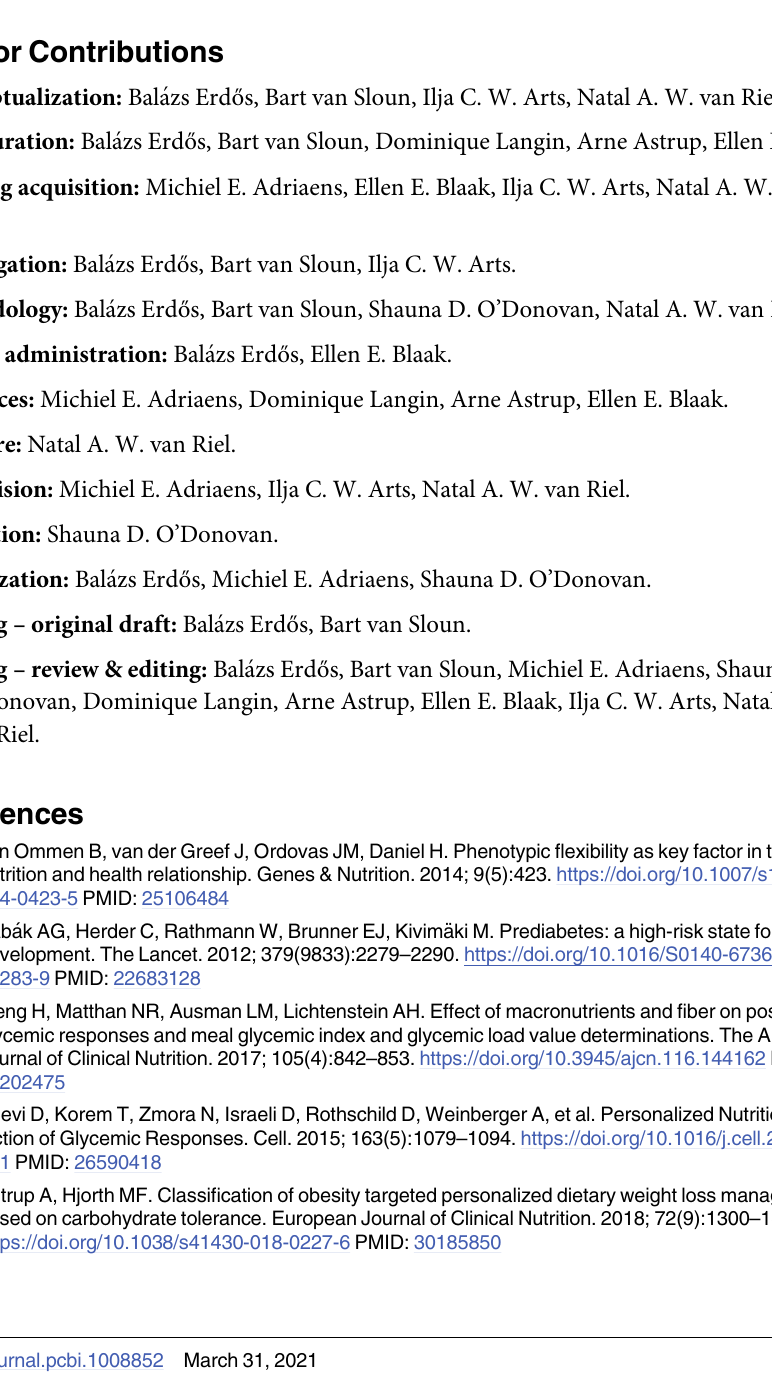
S1 Table. Criteria for prediabetes and diabetes classification used in this study. Based on the standard two hour OGTT by the American Diabetes Association. S2 Table. Results of step two of the model selection approach. Sum of squared residuals (SSR) and Akaike Information Criterion (AIC) of the ten best performing candidate models.